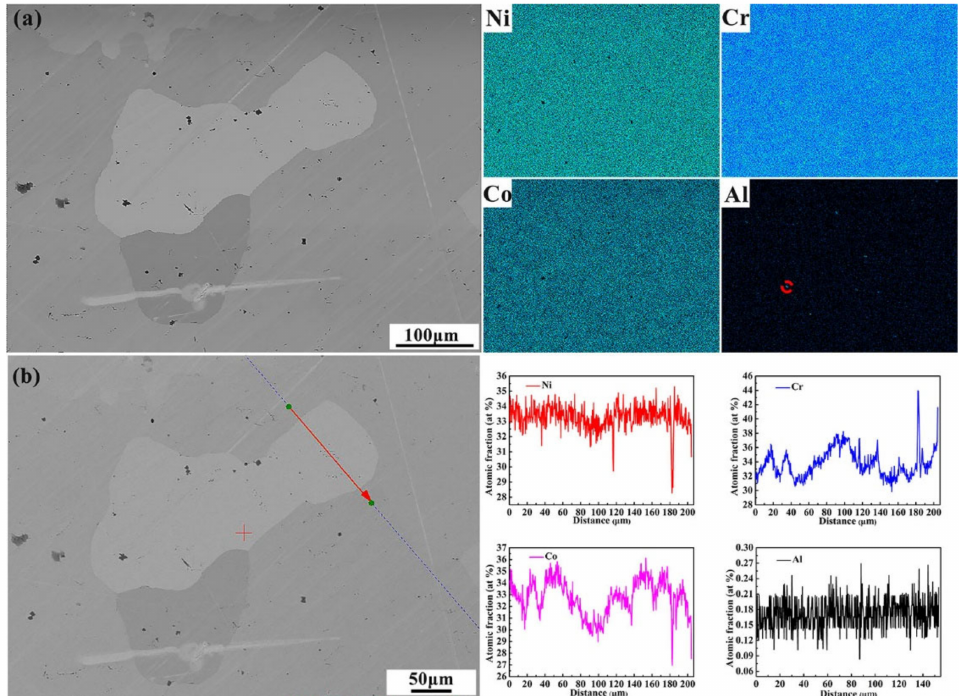
Figure 3. Surface scanning ( a ) and line scanning ( b ) of Ni, Cr, Co, and Al in the as-cast medium- entropy alloy CrCoNiAl 0.014 detected by electron probe microanalysis (EPMA). The red arrow in Figure ( b ) shows the direction of the line scanning